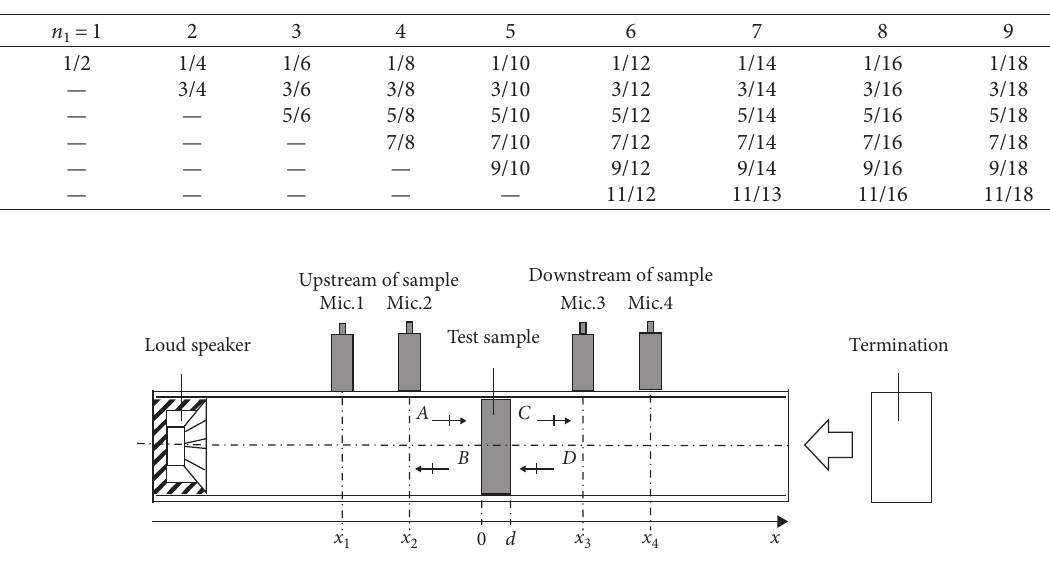
Figure 11: Schematic diagram of the two-load method.